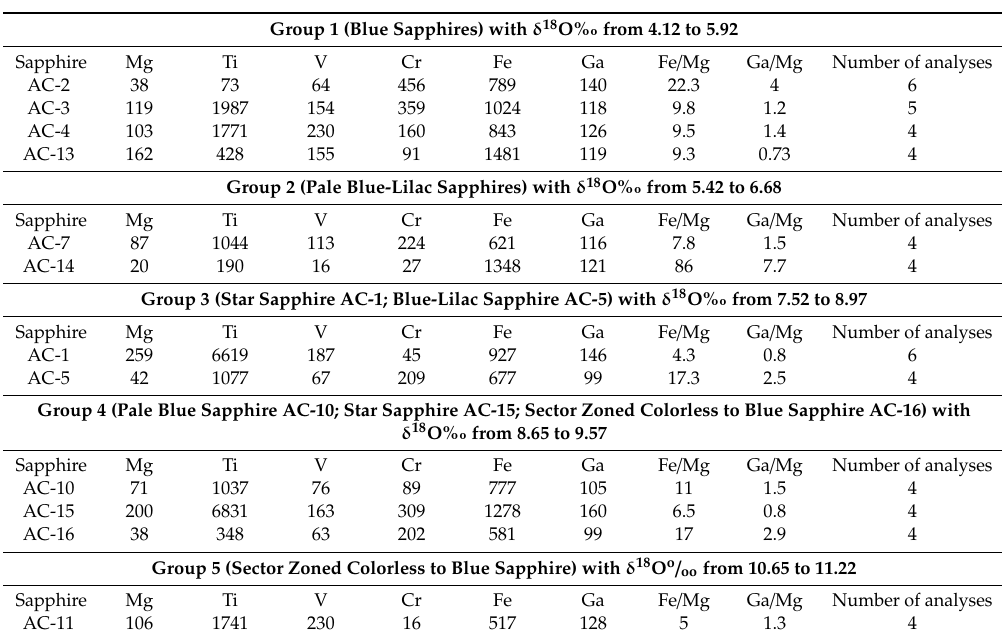
Table 4. Groupings based on δ 18 O% (cid:24) compositions with their main geochemical characteristics from Harris et al. (2017)